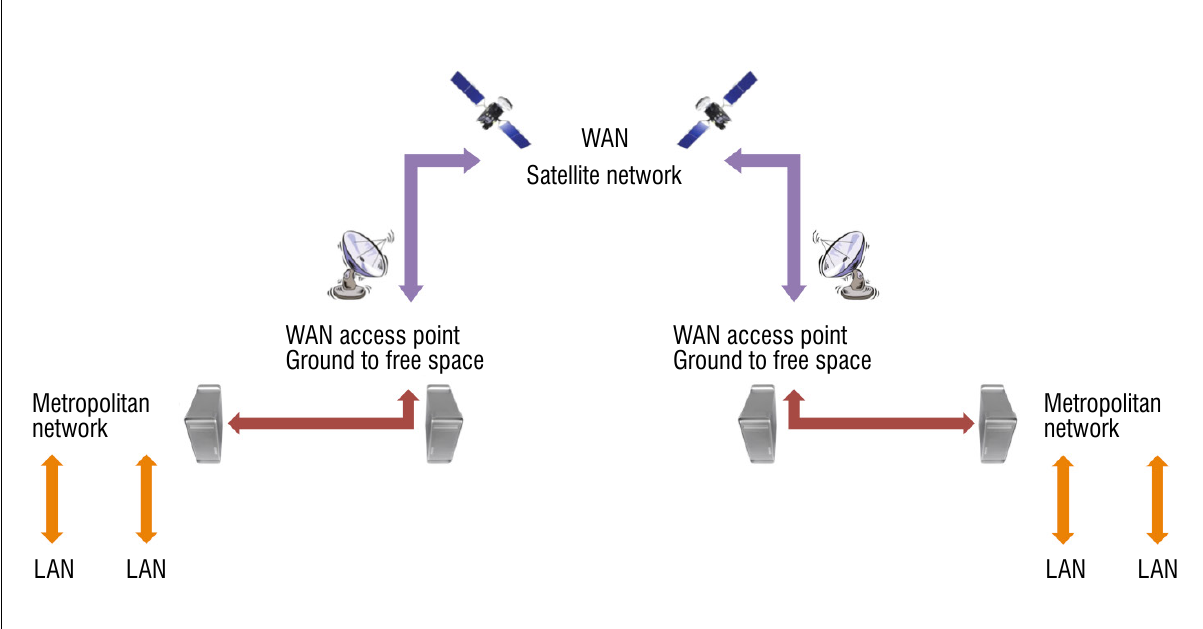
WAN Satellite network